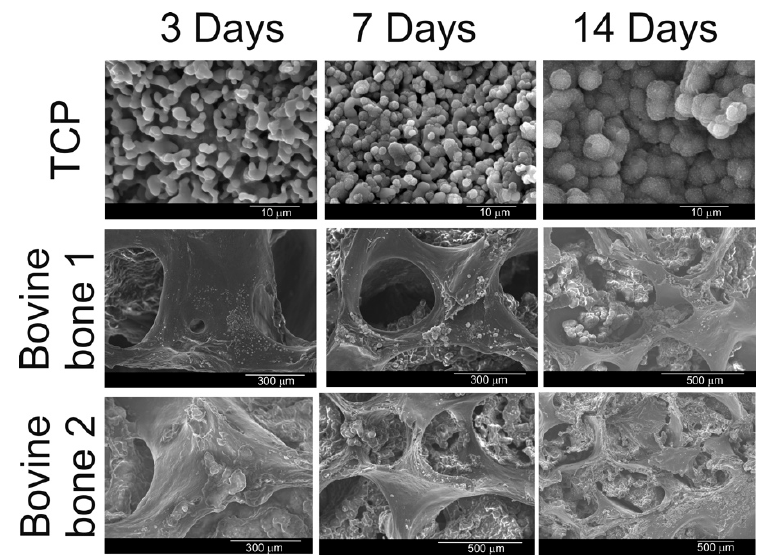
Figure 8. SEM micrographs of the scaffolds soaked in SBF for 3, 7, and 14 days.